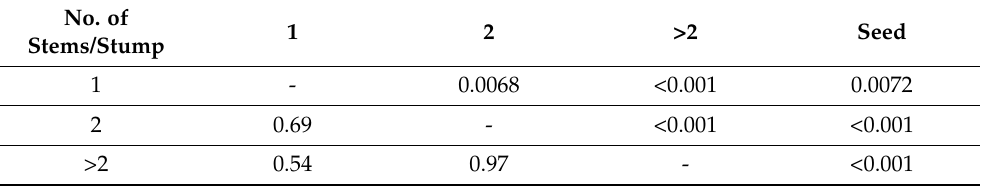
Figure 4. Change overtime of ( a ) DBH, ( b ) total height, ( c ) DBH in first and third quartile and ( d ) height in first and third quartile. Solid line with no symbols indicates the mean value. Table 2. p -values of the Scheffe multiple comparison tests for DBH (above main diagonal) and height (below main diagonal) provided by the nested repeat measurements linear mixed model of the DBH and total